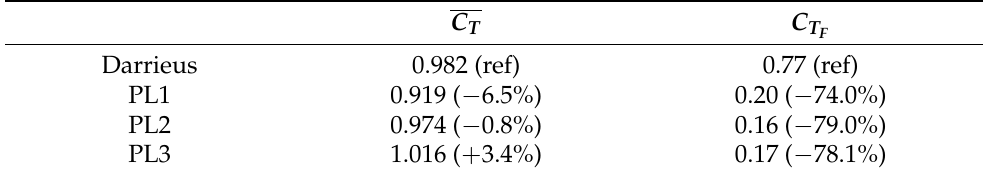
= C Tmax C Tmin ) values for the fixed F −